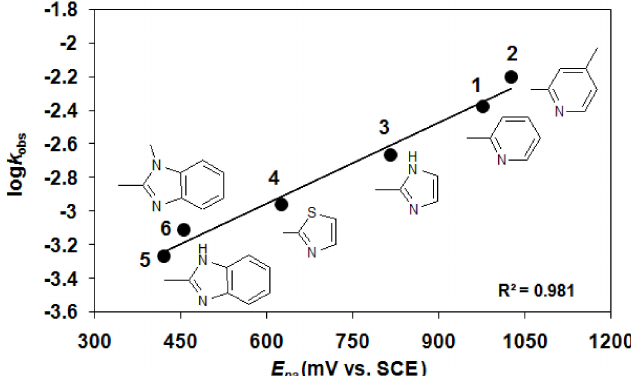
Figure 9. Time-dependent UV–vis spectra of a 0.16 mM solution of morin at pH 10 in the presence of 1.6 µ M [Mn II (HL 1 )Cl 2 ] ( 1 ) under air at 25 ◦ C without H 2 O 2 . ( B ) Kinetic traces of complexation and oxidation of morin.